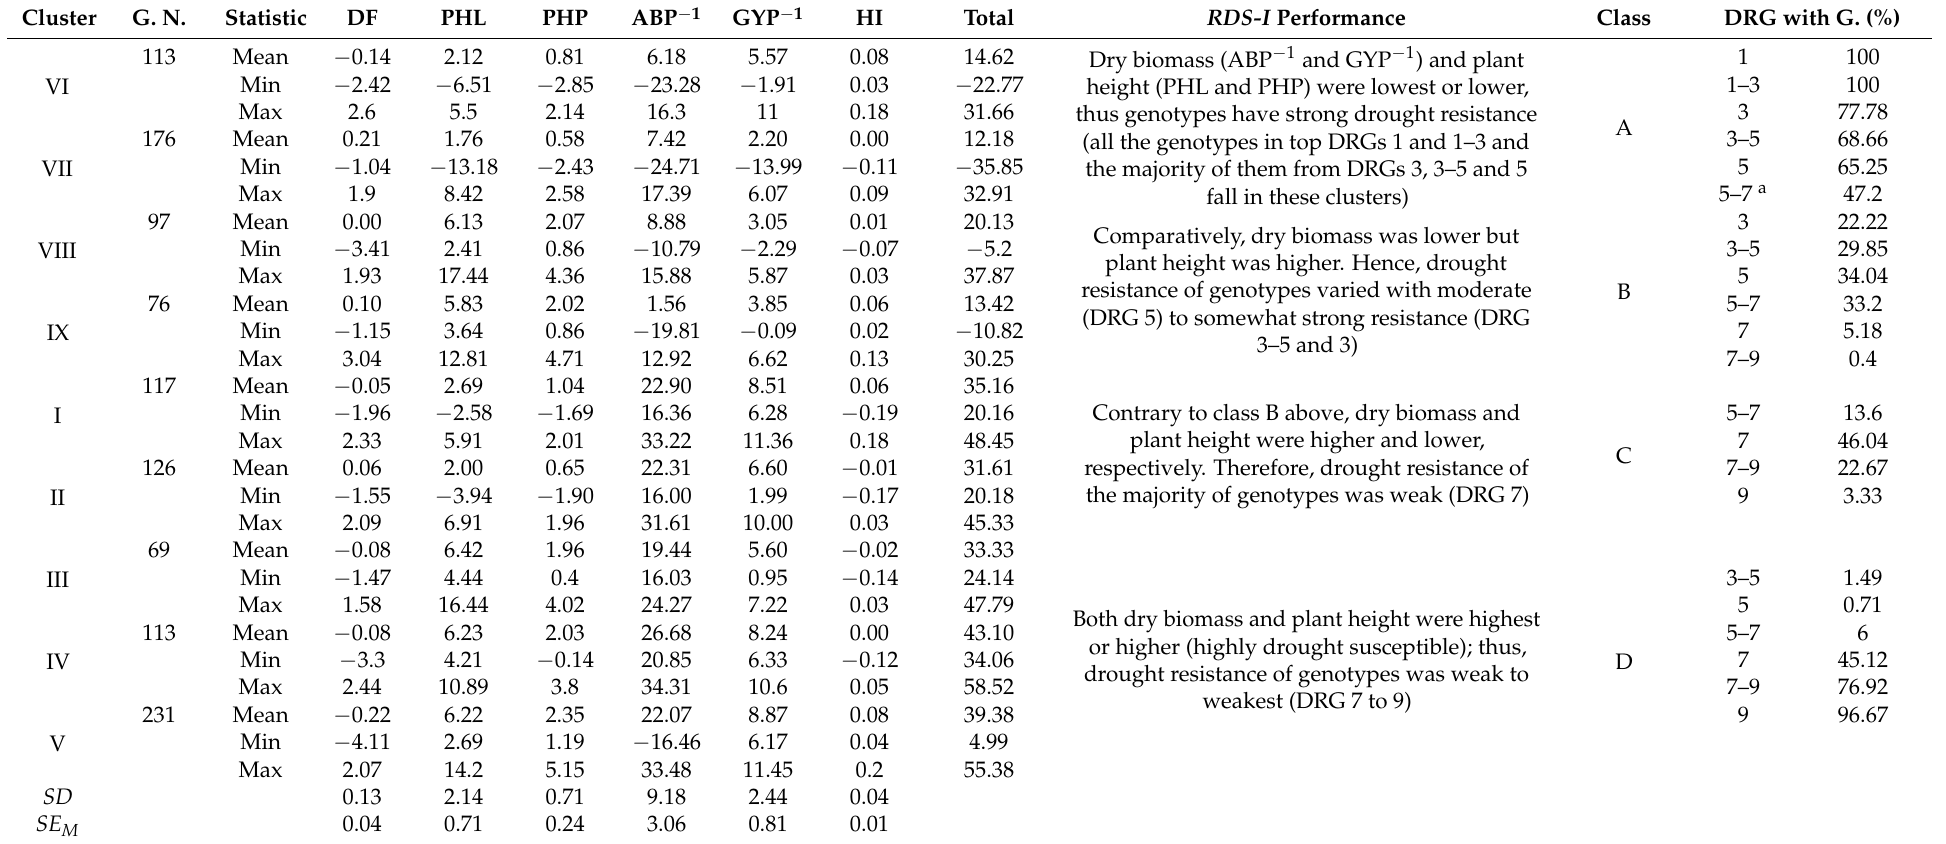
Table 8. Clusters with integrated relative drought stress susceptibility ( RDS-I ) for six traits and their relation to drought resistance grade (DRG). Cluster G.